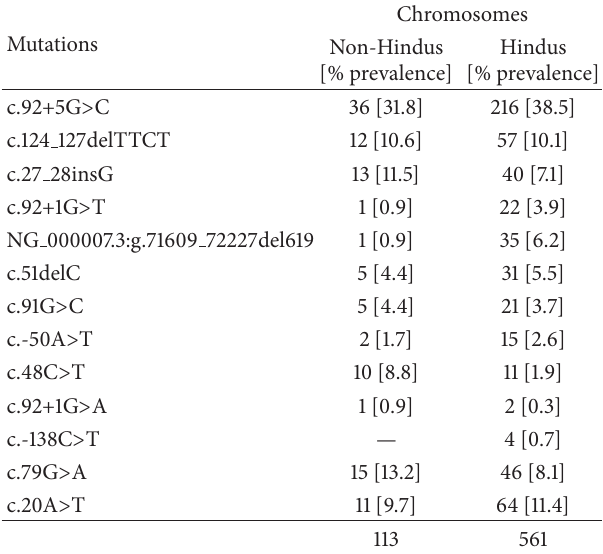
Table 1: Spectrum of mutation in Hindu and Non-Hindu